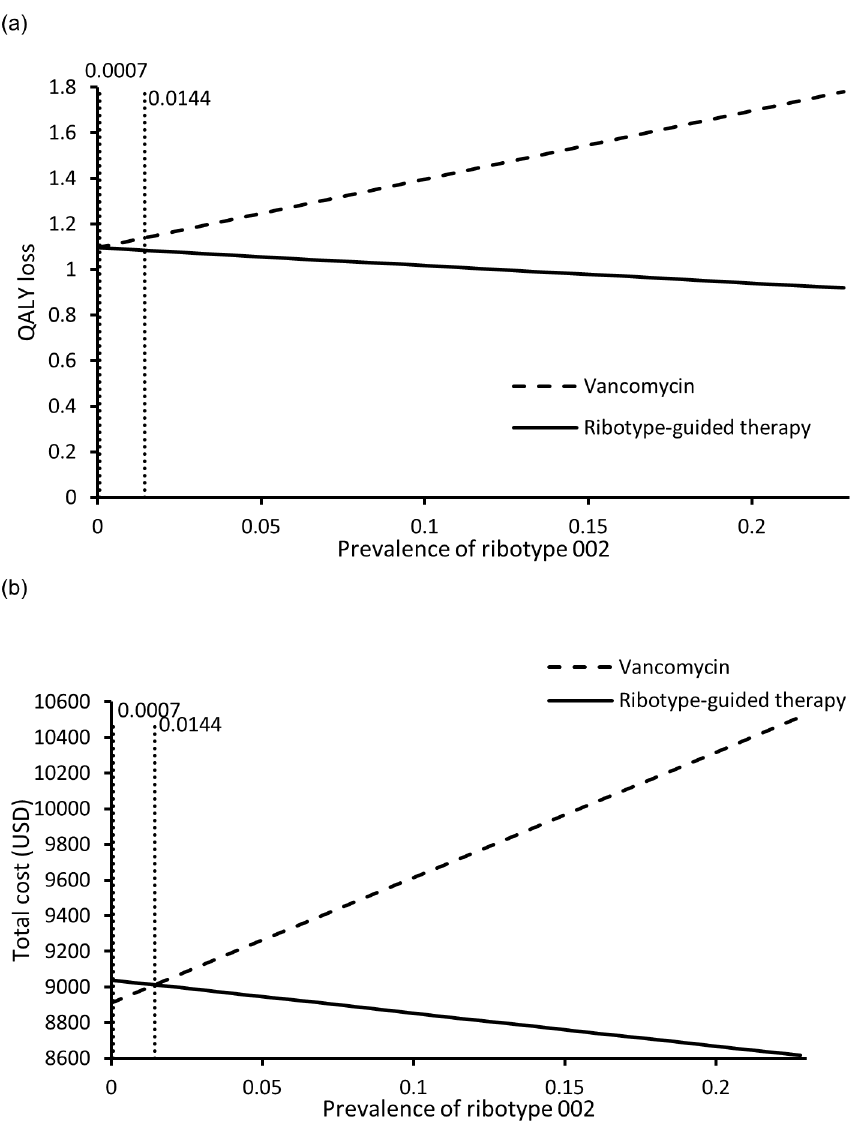
Fig 3. QALYs loss (a) and total cost (b) of each strategy against variation of prevalence of ribotype